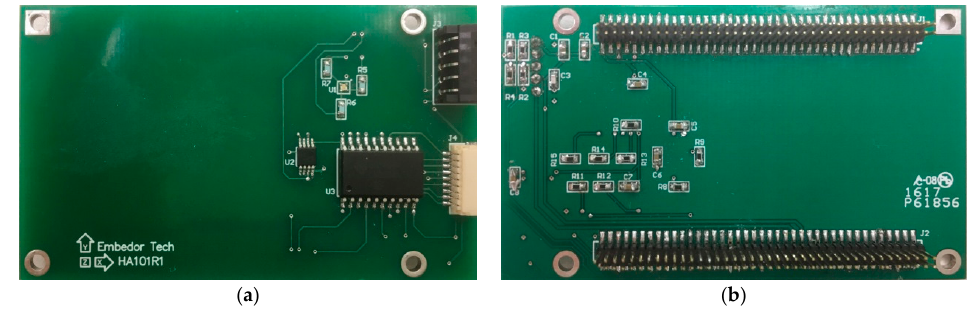
Figure 6. PCB design of high-sensitivity sensor board. ( a ) Top side; ( b ) Bottom side.